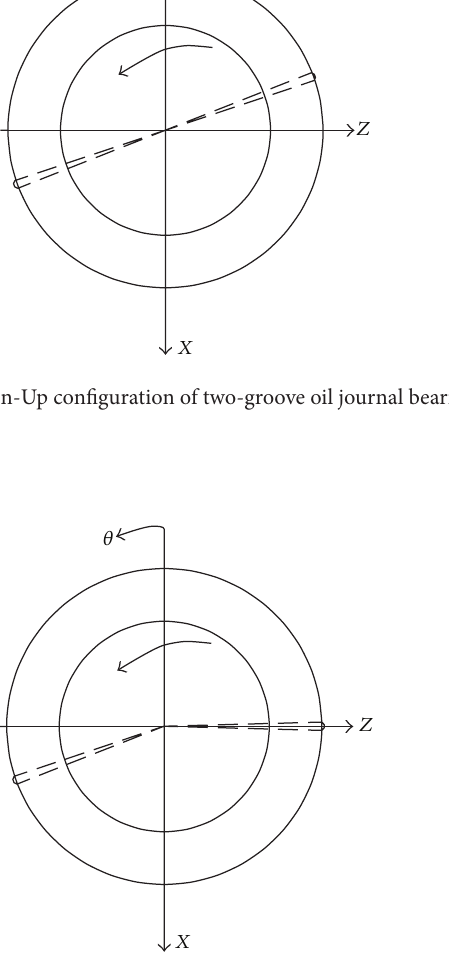
Figure 8: Dn-Hz configuration of two-groove oil journal bearing.